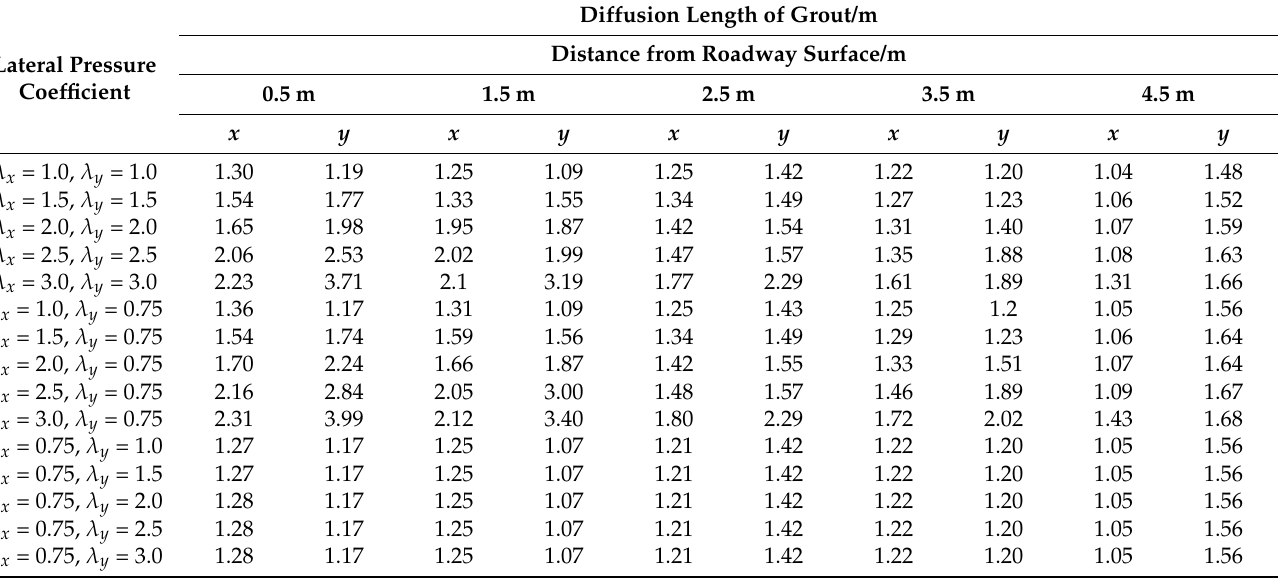
Table 4. Diffusion lengths of grout in different directions at different distances from the roadway